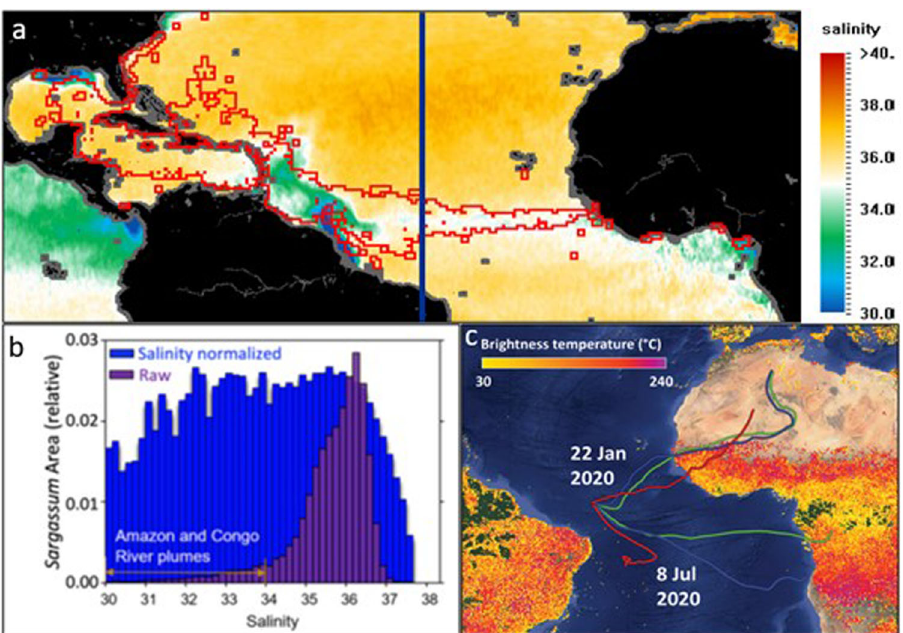
Fig. 4 Spatial distribution of Sargassum in relation to salinity and aerosol trajectories. a Sargassum distribution (red empty squares) overlaid on salinity derived from the Soil Moisture Ocean Salinity (SMOS) satellite mission, both for July 2018. The blue line marks the longitude of 38 ˚ W that the Amazon River plume hardly reaches. b Distribution of Sargassum as a function of salinity (purple) for 2011 to 2019, where statistics are calculated from 108 monthly mean maps over the cumulative Sargassum footprint. Here, the raw data (purple) shows Sargassum areal coverage in each salinity increment, relative to the total coverage (i.e., all purple bars sum to 1.0). The Sargassum coverage in each salinity increment is divided by the water area in the same salinity increment, resulting in the “ salinity normalized ” distribution (blue). The Sargassum distribution data were obtained on National Centers for Environmental Information (NCEI) Accession 0190272 14 . c Hybrid Single-Particle Lagrangian Integrated Trajectory model (HYSPLIT) air mass back trajectories (10-day) from 3 ° N, 34.6 ° W at 500 m (red), 1000 m (blue), and 1500 m (green), shown with the active fi res in Africa and South America observed during Apr 2020 to Mar 2021 (from fi rms.modaps.eosdis.nasa.gov/download 85